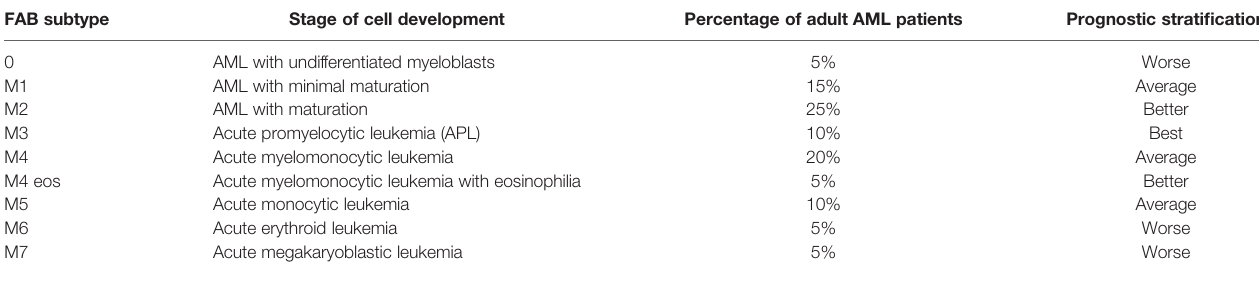
TABLE 2 | WHO classi fi cation of